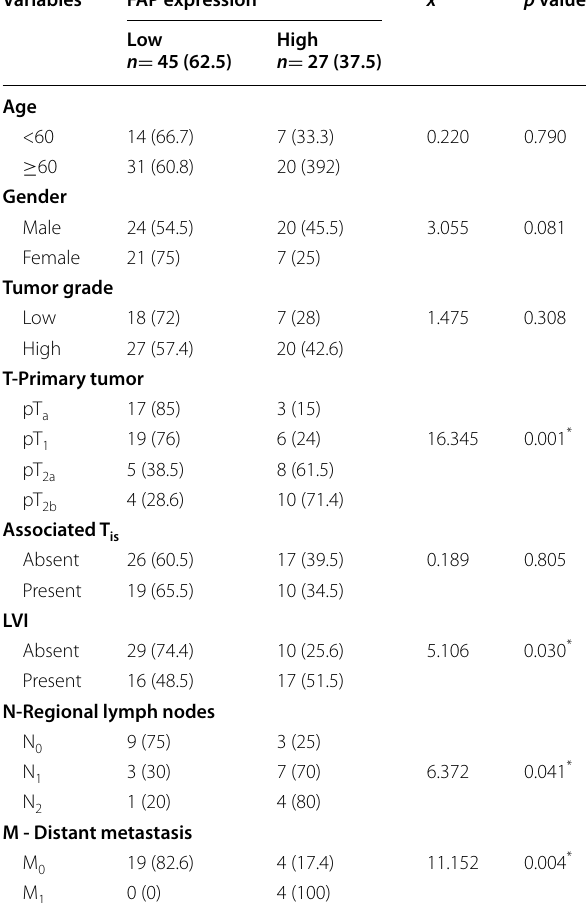
Table 3 The relation between FAP expression and clinicopathological characteristics